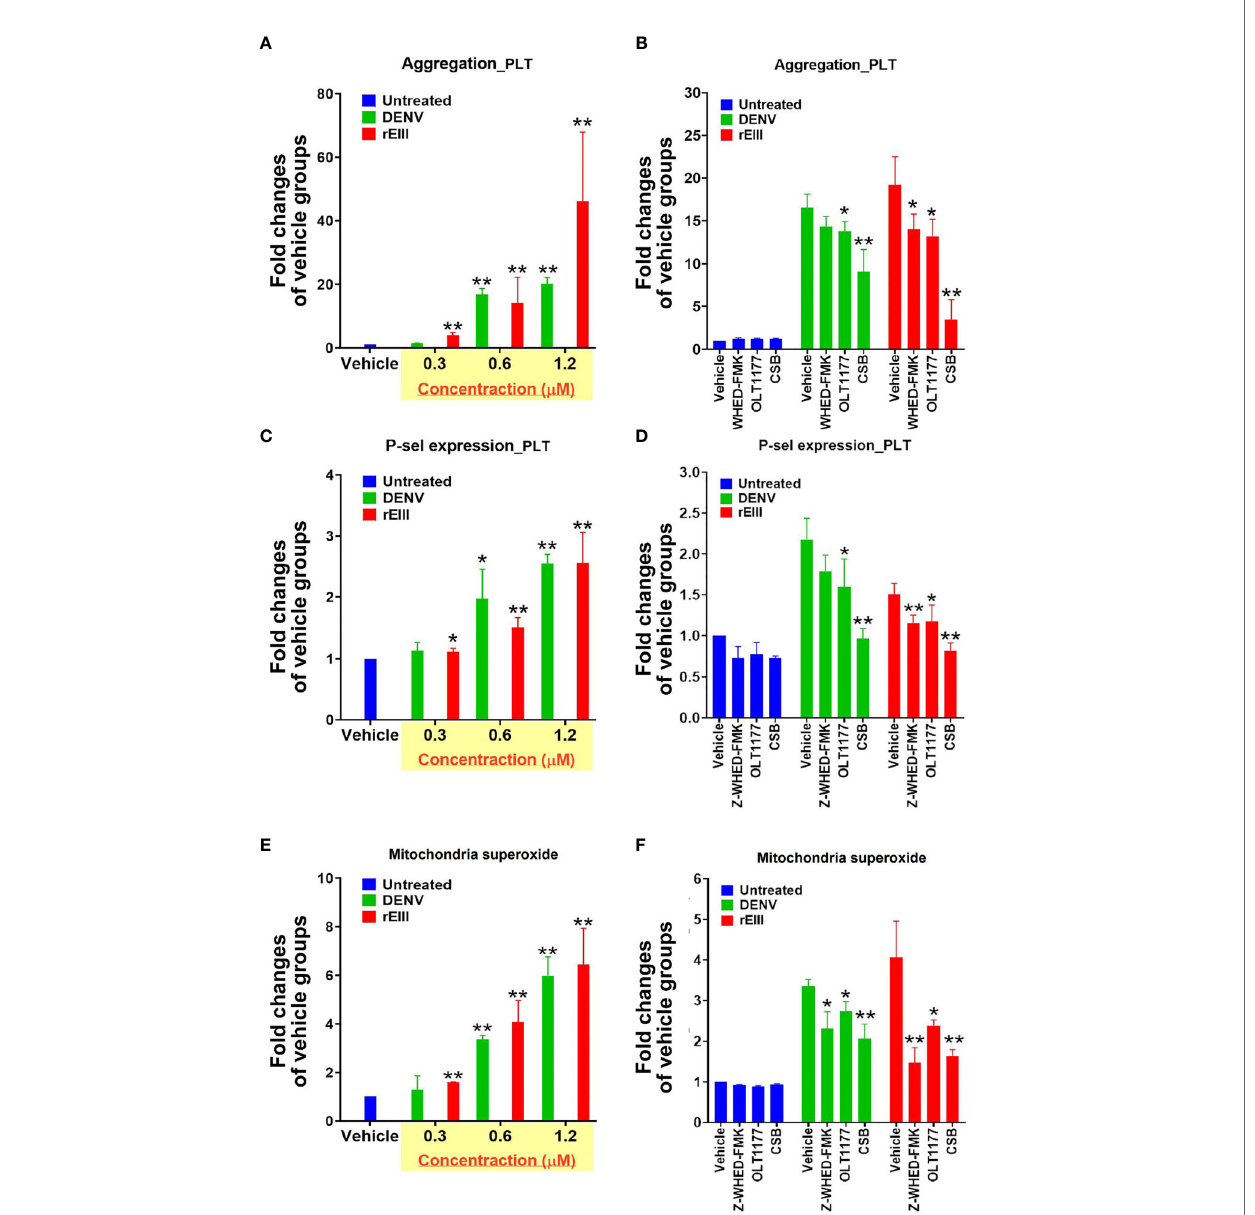
FIGURE 6 | Nlrp3 and caspase-1 inhibitors protect platelets from DENV- and rEIII-induced activation. DENV- and rEIII-induced platelet activation, including (A, B) platelet aggregation, (C, D) platelet surface P-selectin expression, and (E, F) mitochondrial superoxide levels, could be suppressed with the treatments with Nlrp3 and caspase 1 inhibitors Z-WHED-FMK (10 m M) and OLT1177 (10 m M), respectively (B, D, F) . n = 6, * P < 0.05, ** P < 0.01 vs. respective vehicle